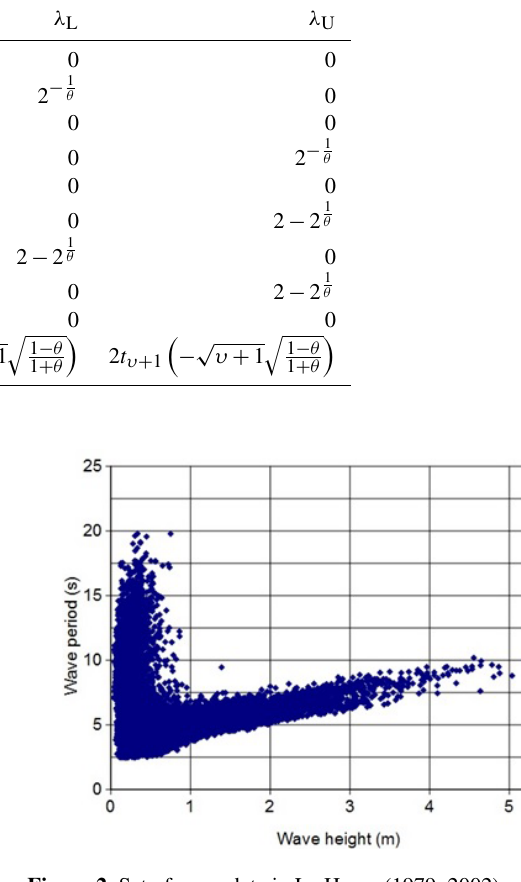
Figure 2. Set of wave data in Le Havre